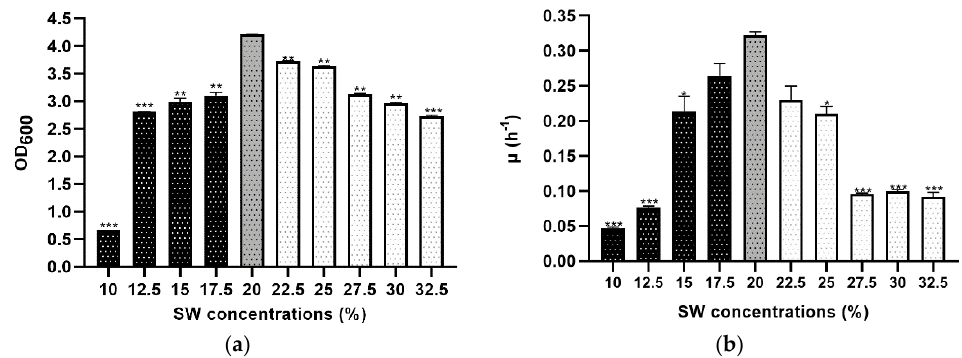
Figure 1. Effect of salinity stress on the growth profile of Hfx. mediterranei R4 grown in Hm-DM. Data are based on three independent cultures. ( a ) Maximum OD 600 in stationary phase (reached at different times). ( b ) Average growth rate. Plotted values are the mean of triplicate measurements, and error bars represent ± SD. * p ≤ 0.05; ** p ≤ 0.01; *** p ≤ 0.001. In grey, the control; in black, lower concentrations of SW%; in white, higher concentrations of SW%.